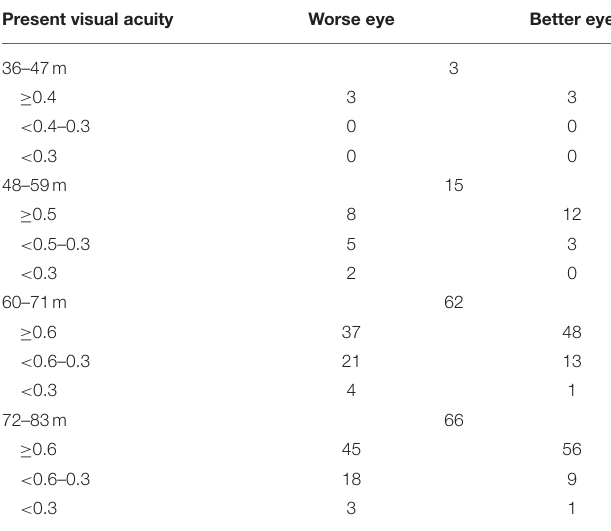
TABLE 5 | Distribution of present visual acuity of the children wearing spectacles. Present visual